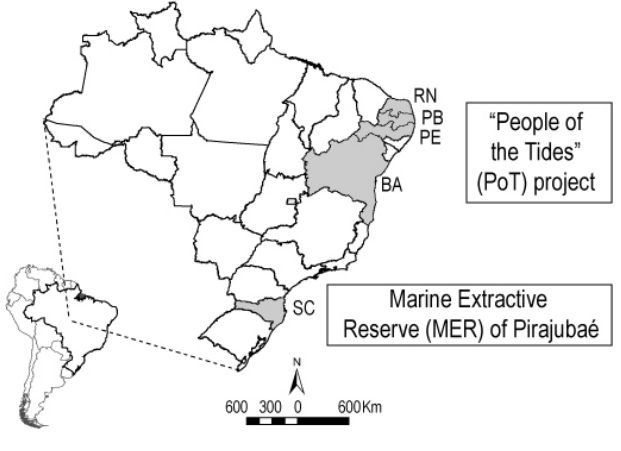
Fig. 1 . Location of Brazil’s two experiences in comanagement of Venus clam ( Anomalocardia brasiliana ): “People of the Tides” project (PoT), in the states of Rio Grande do Norte (RN), Pernambuco (PE), Bahia (BA) and Paraíba (PB), and the Marine Extractive Reserve (MER) of Pirajubaé, in the state of Santa Catarina